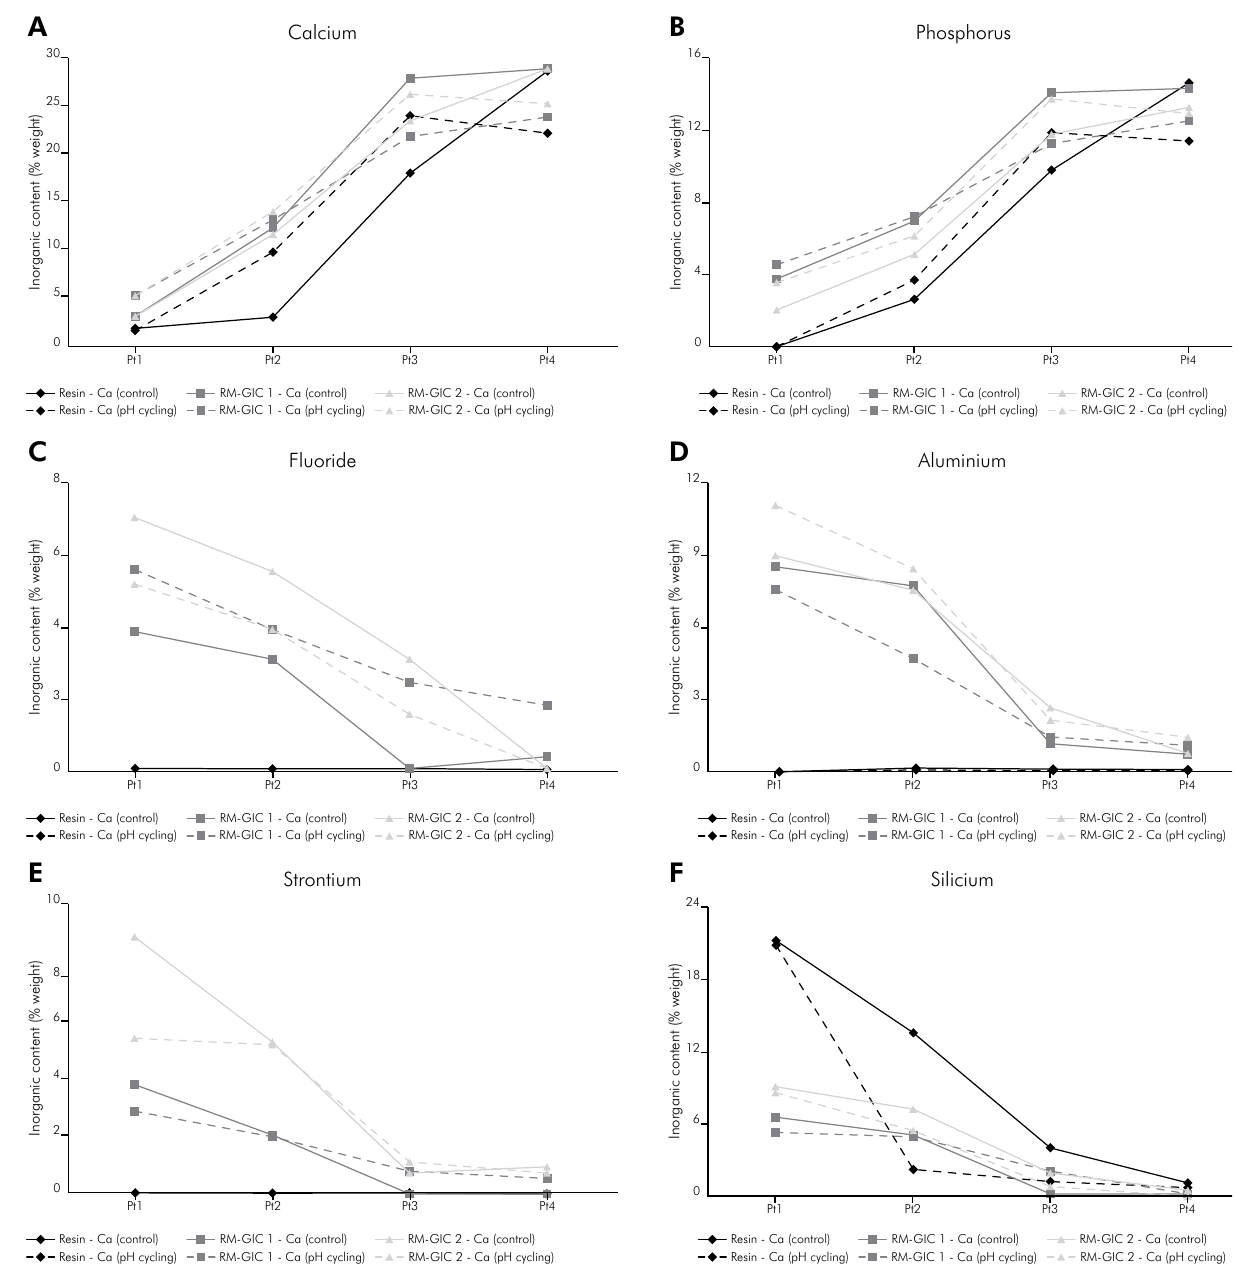
Figure 2. Ca (A), P (B), F (C), Al (D), Sr (E), and Si (F) content within each material group for control and samples submitted to pH cycling among points: (MB) material bulk; (MI) material interface; (EI) enamel interface; (EB) enamel bulk.